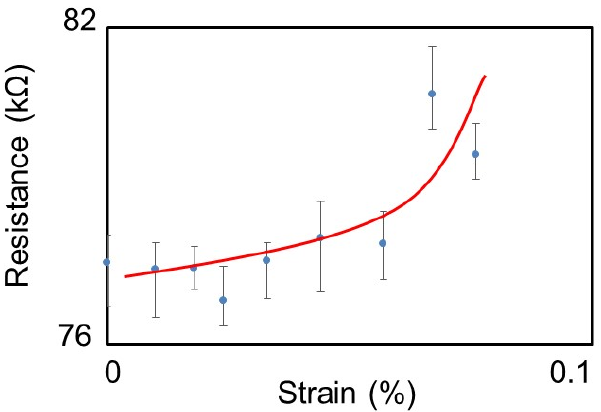
Figure 8. Strain-induced change of the electrical resistance of 50 nm-wide GNR.